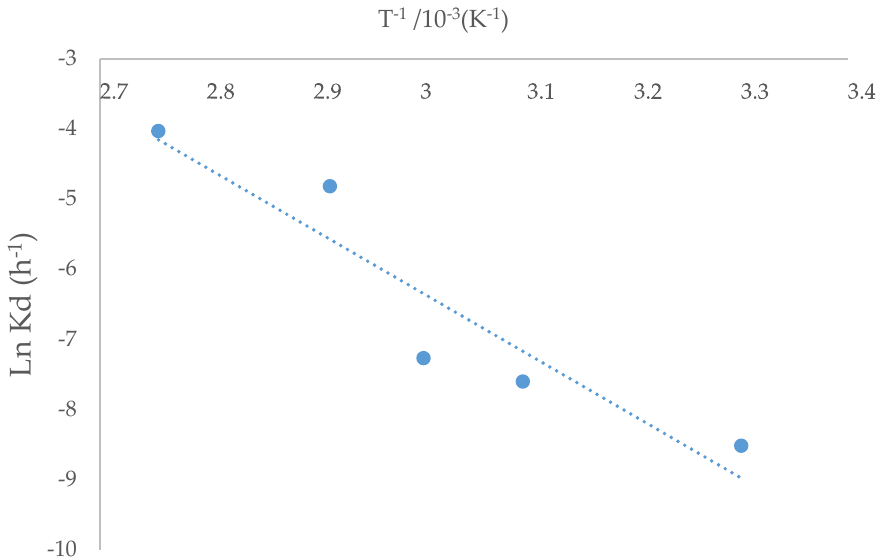
Figure 7. Arrhenius graph for chalcopyrite extraction using ionic liquid at 20% ( v / v ) and 100 g / L of Br − . The kinetic constant k d for each temperature was obtained based on the slopes shown in Figure 7.